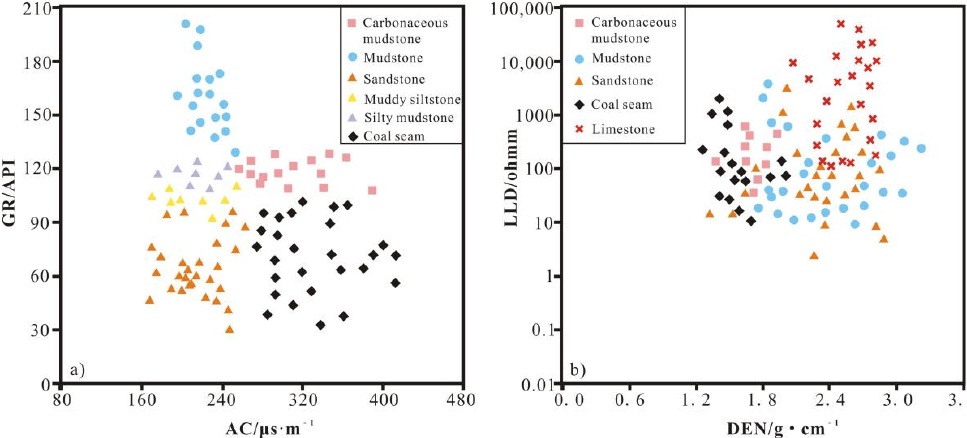
Figure 3. ( a ) AC-GR crossplot of different lithologies of the Taiyuan to Shanxi Fms. ( b ) LLD-DEN crossplot of different lithologies of the Taiyuan to Shanxi Fms.